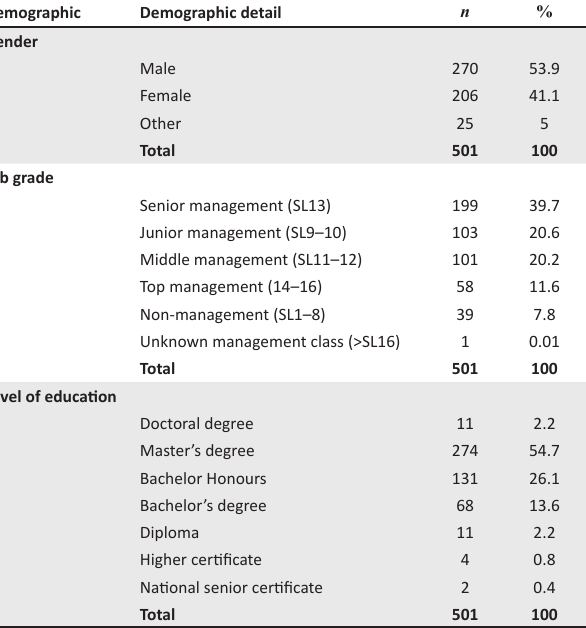
TABLE 1: Demographic information of respondents. Demographic Demographic